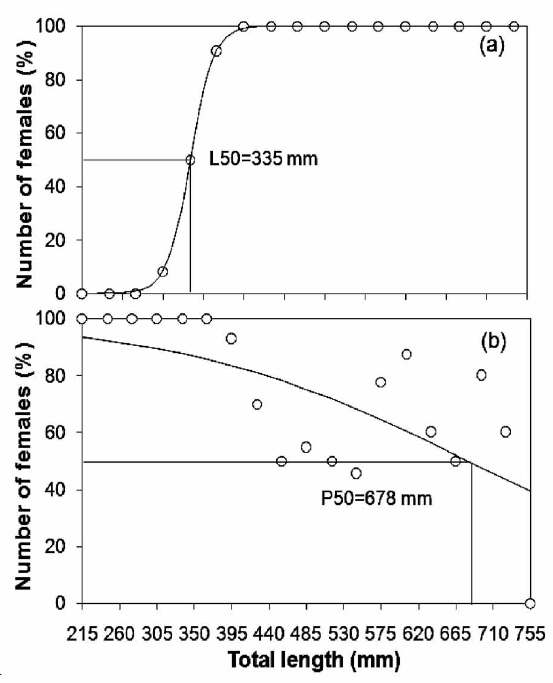
Fig . 6. – Percentage of mature females and maturity ogive (a), and percentage of females as a function of total length and the ogive of the female proportion for each size classes (b) for Mycteroperca fusca caught between January 2004 and December 2005 in waters of the Canary Islands. L50 indicates length at which fifty per cent of the specimens had become mature and P50 length at which 50% of the females reverted to